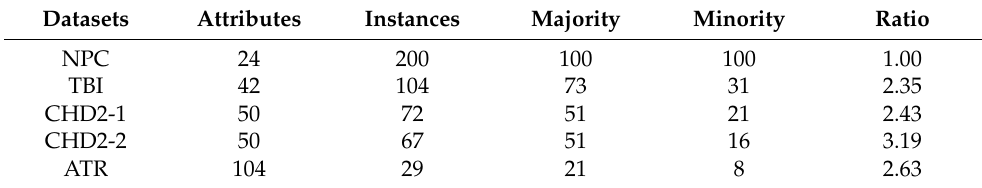
Table 5. The summary of five